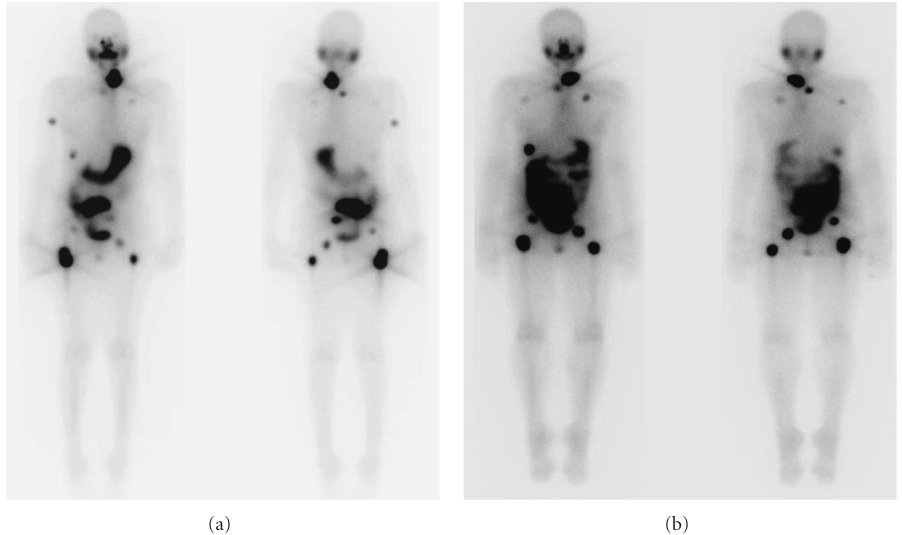
Figure 2: Whole-body radioactive iodine (RAI) scan after the first (a) and second (b) RAI treatments.